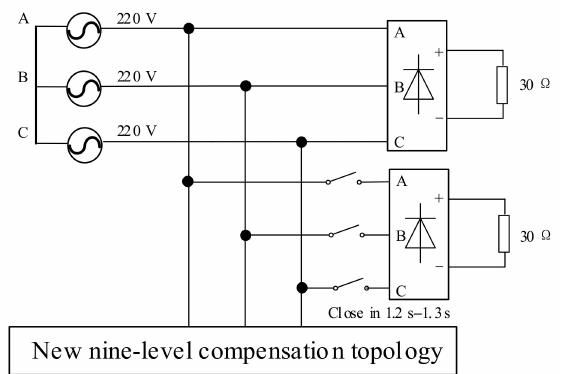
Figure 12. Balanced load